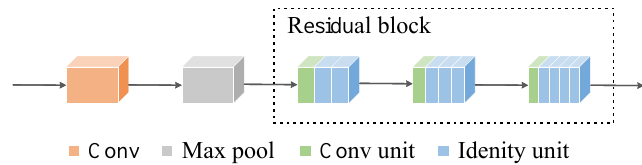
Figure 2. ResNet feature extraction structure.